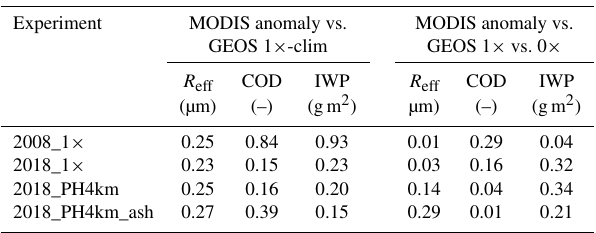
Table 6. R 2 values comparing GEOS normalized zonal anomalies for ice clouds against MODIS.